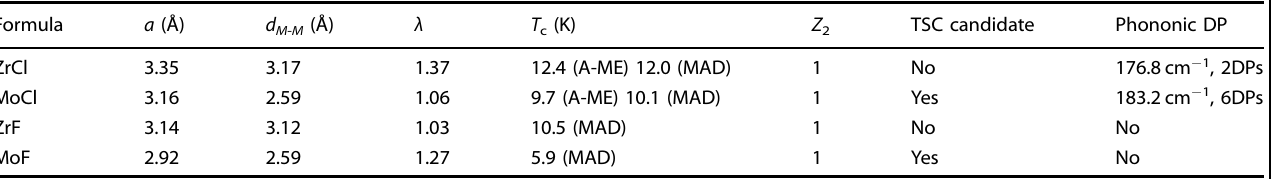
Table 1. Structural, superconducting and topological properties of 2D MX ( M = Zr, Mo; X = F, Cl). Formula